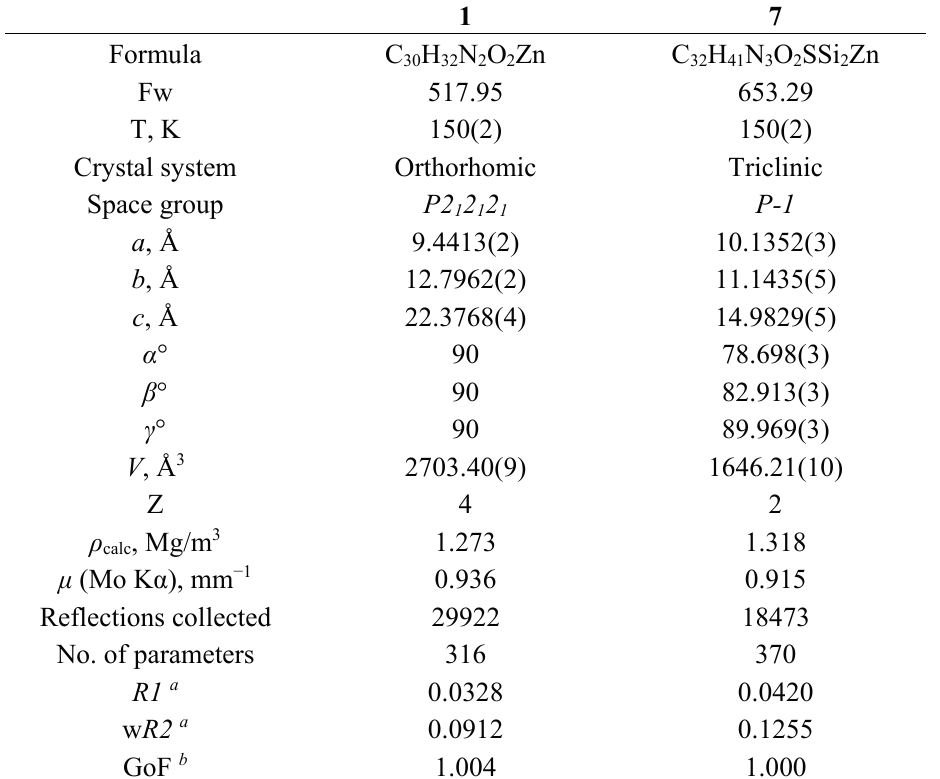
Table 3. Summary of crystal data for compounds 1 and 7